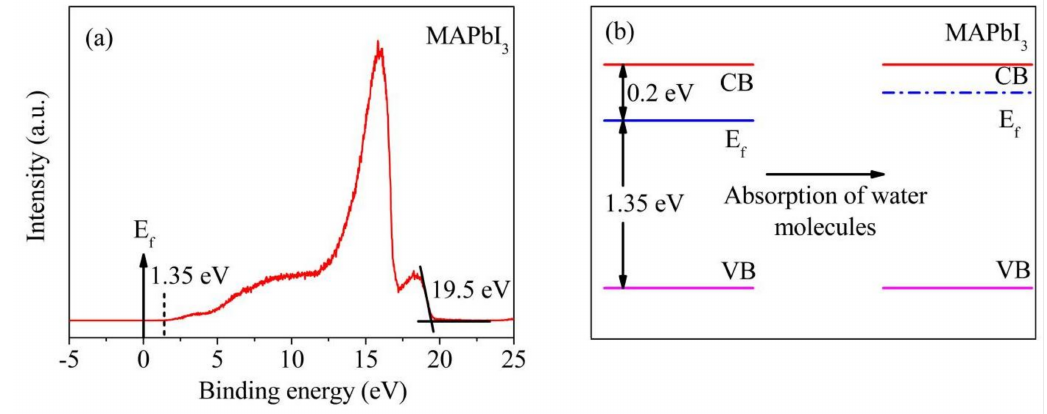
Figure 10. ( a ) The direct UPS spectrum of the as-grown bare MAPbI 3 ; and ( b ) the energy level diagrams of as-grown MAPbI 3 in the cases before and after absorbing water